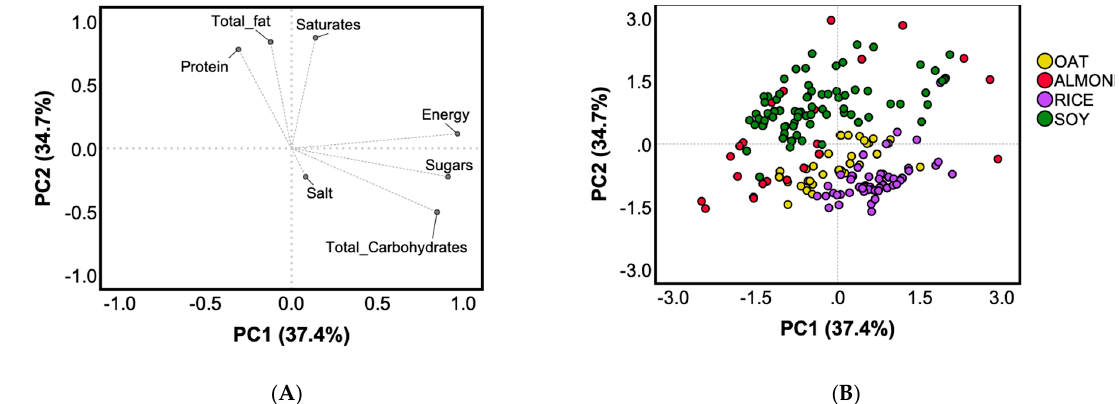
Figure 1. Principal component analysis (PCA) based on the nutritional composition of products belonging to soy, rice, almond or oat drinks (energy (kcal / 100 mL), total fat (g / 100 mL), saturates (g / 100 mL), carbohydrate (g / 100 mL), sugars (g / 100 mL), protein (g / 100 mL), and salt (g / 100 mL)). Loading plots ( A ) of principal component (PC) 1 versus PC2; score plots ( B ) of the nutrition composition for each plant-based drink analyzed from PC1 and PC2.